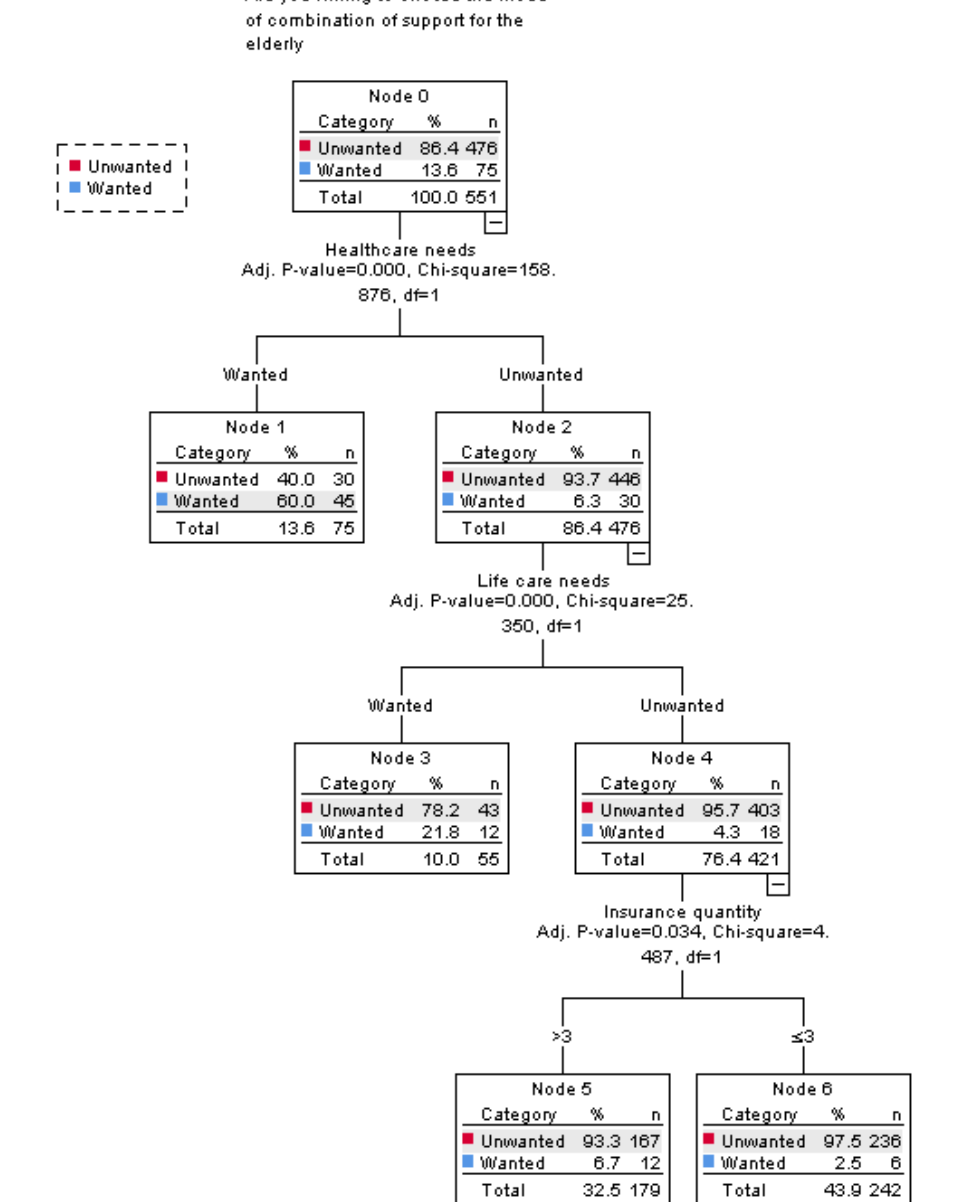
Figure 4. Decision tree model of the factors influencing the elderly’s willingness to select the com- bined medical care and nursing care model. medical care and nursing care